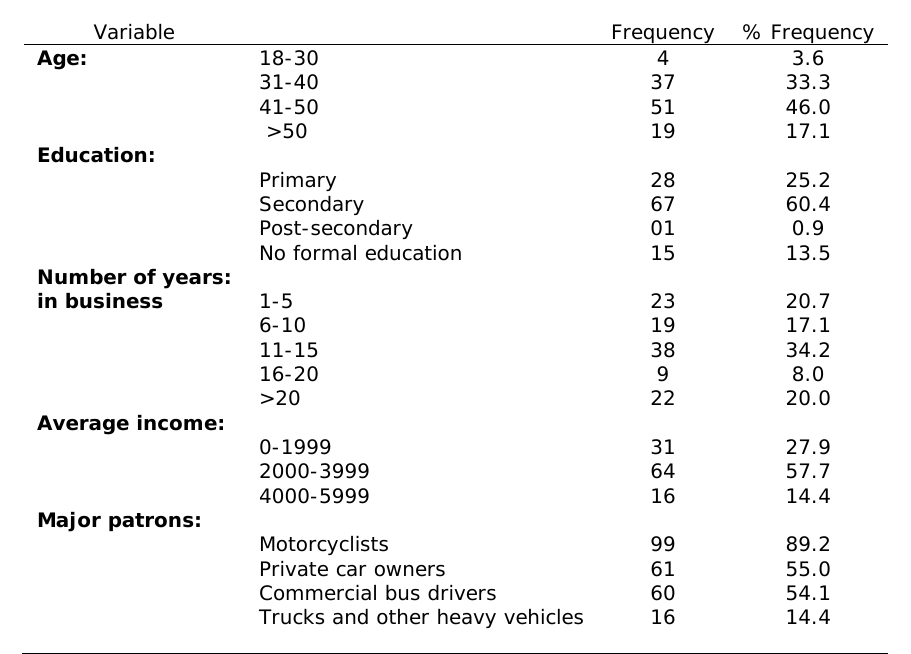
Table 3. Sociodemographic characteristics of